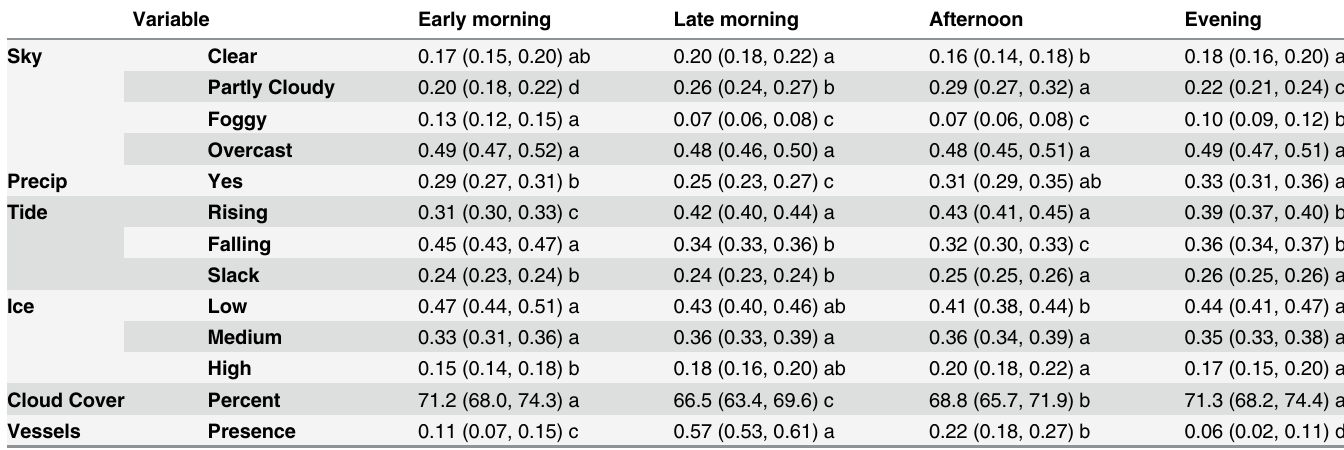
Table 8. Comparison of covariates by time-of-day